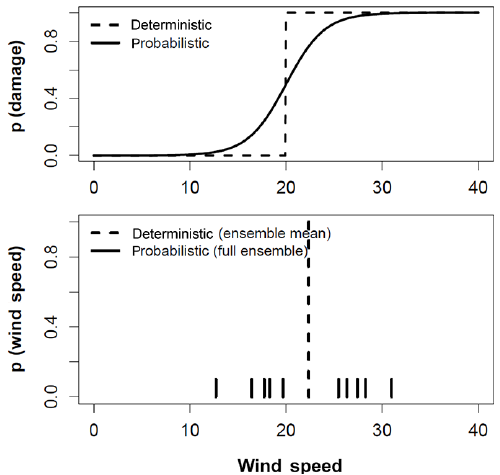
Figure 1. Illustration of the methodology to derive probabilistic impact prediction from ensemble-forecasted gust wind speed. Top panel: probabilistic storm damage function – logistic regression curve – relating the forecasted gust wind speed to a probability of damage occurrence. The dashed line indicates the deterministic ver- sion of such a damage function being zero below the critical thresh- old for gust winds and one above it respectively. Bottom panel: il- lustration of gust winds forecasted by a 10-member ensemble in solid lines. Dashed line indicates the ensemble